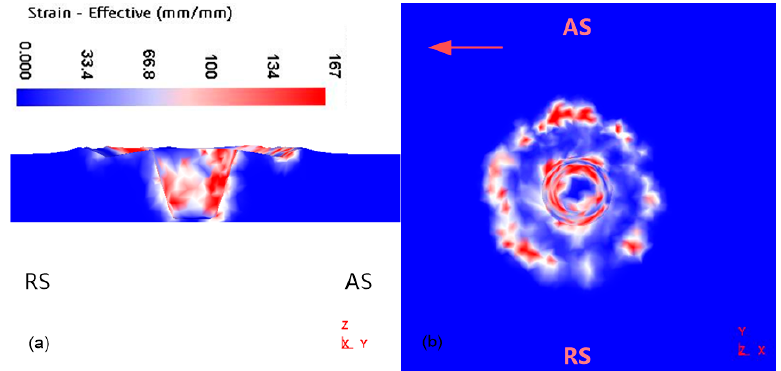
Figure 14. E ff ective strain distribution of spindle speed 900 rpm. ( a ) Cross section distribution Figure 14. Effective strain distribution of spindle speed 900 rpm. ( a ) Cross section distribution perpendicular to welding direction; ( b ) the surface distribution of welded perpendicular to welding direction; ( b ) the surface distribution of welded joints. Figure 14. Effective strain distribution of spindle speed 900 rpm. ( a ) Cross section distribution perpendicular to welding direction; ( b ) the surface distribution of welded joints. Figure 14. Effective strain distribution of spindle speed 900 rpm. ( a ) Cross section distribution perpendicular to welding direction; ( b ) the surface distribution of welded joints.